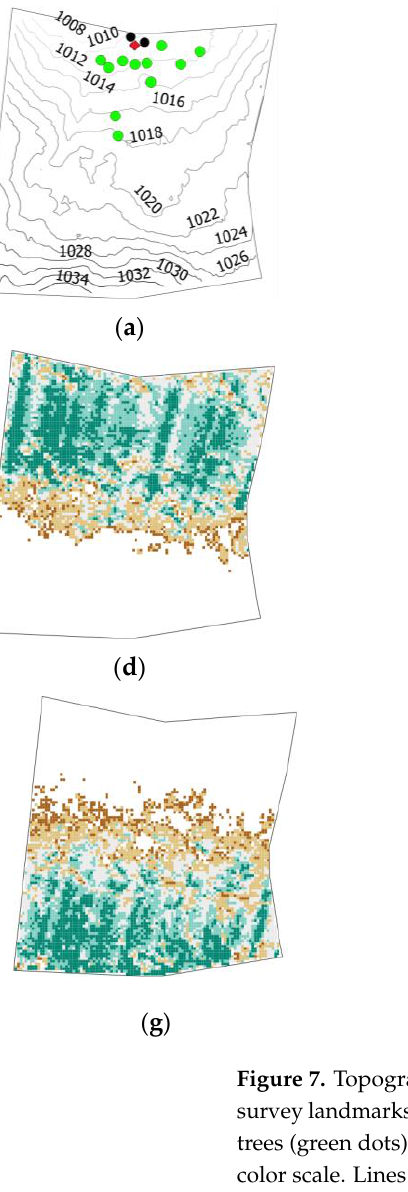
( b ) Figure 8. Topographic and LAS surveys: ( a ) first return density of the merged scan lines; ( b ) third return density of the merged scan lines. The positions of the trees determined via the topographic survey are reported in Fig- ure 9a (dots). The distances between trees positioned via the expeditious survey and via the topographic survey showed an average value of 4.71 m with a standard error of 0.73 m. This average value was larger than the planimetric absolute accuracy of the YellowScan Mapper integrated system, which was 0.6 m at the flying altitude (50 m). However, con- sidering the uncertainties due to the heterogeneity of (i) the size of the crowns of the dom- inant trees (characterized by an average radius μ = 3 .24 m with standard error σ μ = 0.12 m); (ii) the eccentricity of the crown ( μ = 0 .84 m, σ μ = 0.01 m); and (iii) the tree leaning ( μ = 23°, σ μ = 2.5°) and tree height ( μ = 1 6.5 m, σ μ = 0.38, maximum height = 32.4 m), it emerged that the accuracy of the expeditious positioning could be considered acceptable.